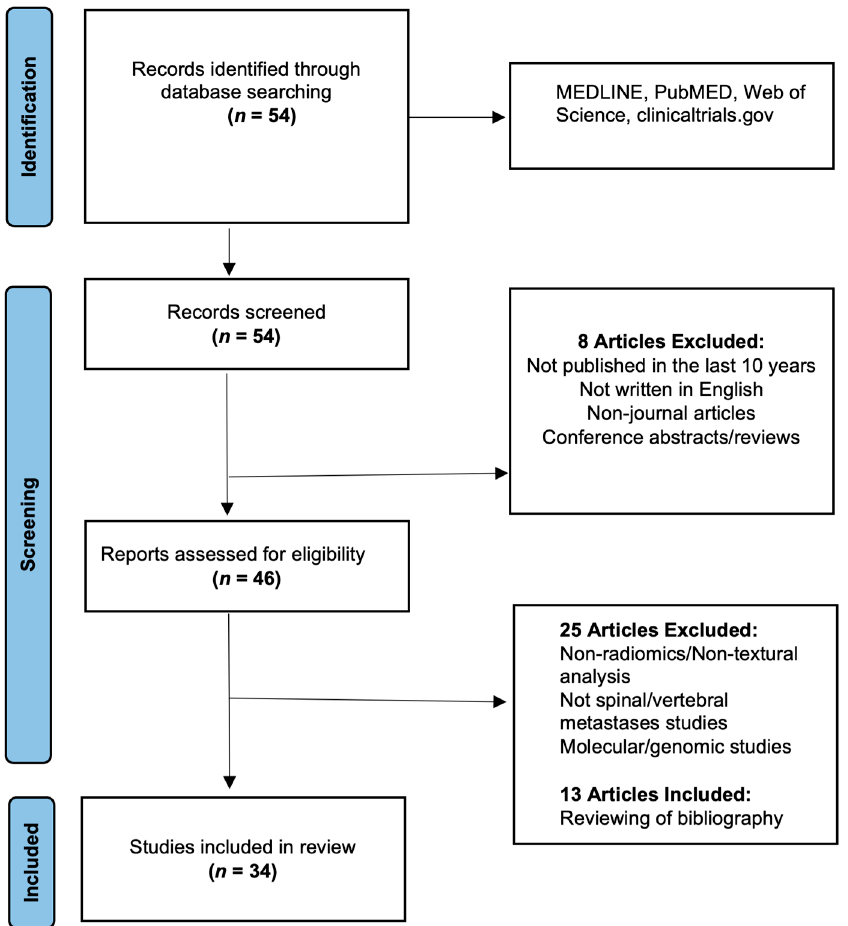
Figure 1. Preferred Reporting Items for Systematic Reviews and Meta-Analyses (PRISMA) flowchart for the study (adapted from the PRISMA group, 2020), which describes the research article selection process.